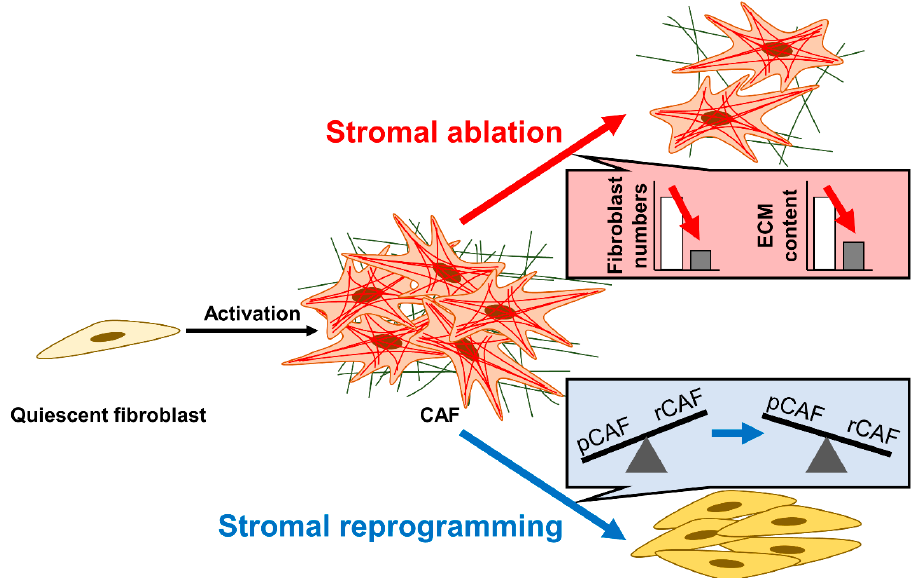
Figure 5. Stromal ablation vs. stromal reprogramming. Stromal ablation (red arrow) aims to reduce stromal content by decreasing fibroblast numbers and ECM content. In contrast, stromal reprogramming (blue arrow) aims to shift the balance from CAFs with tumor-promoting functions (pCAFs) to CAFs with tumor-restraining functions (rCAFs). The insets schematically depict the objectives of each strategy.